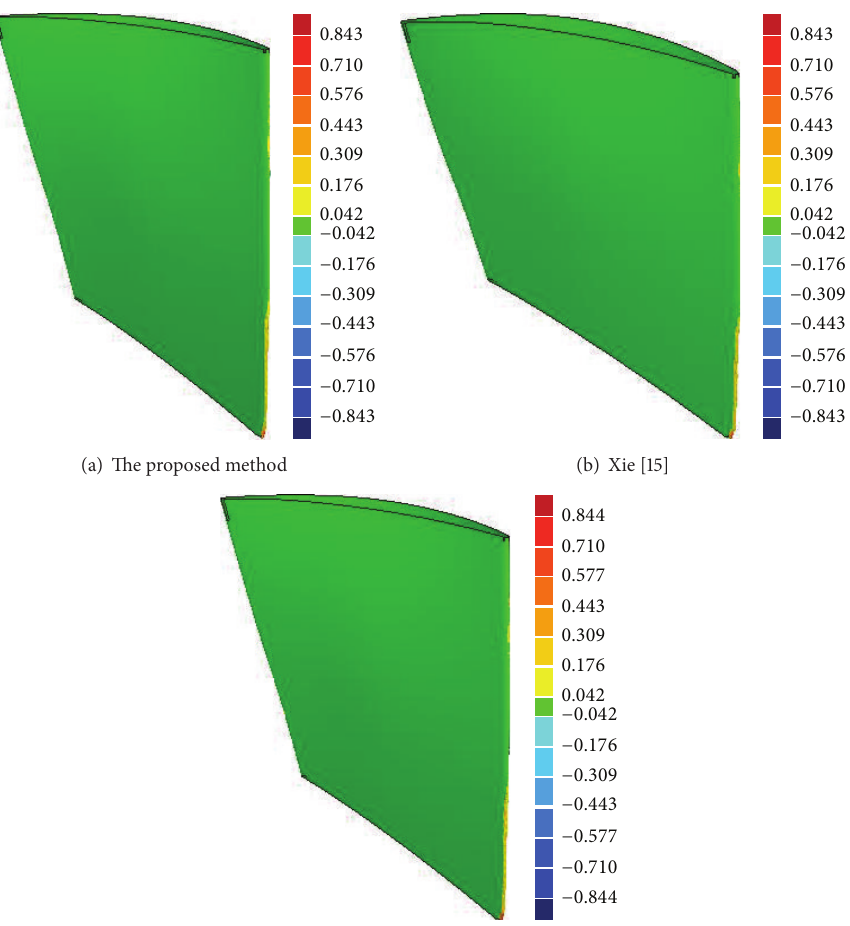
Figure 20: Shape error of different methods for complex